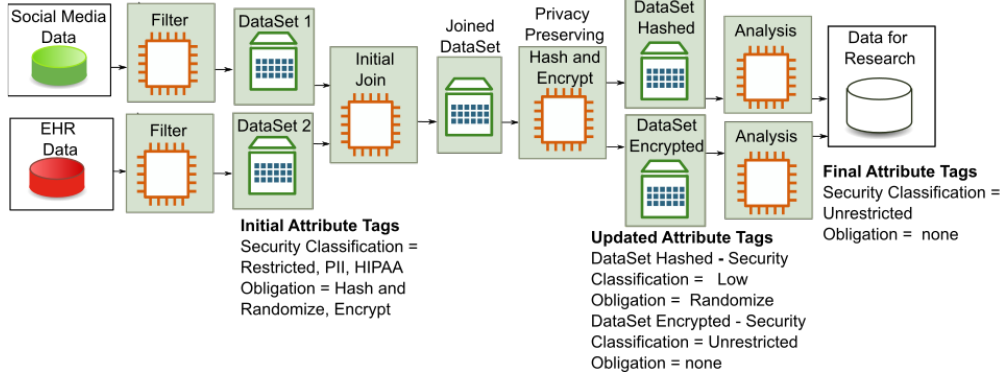
Figure 10. Lifecycle of data processing for security experiments.